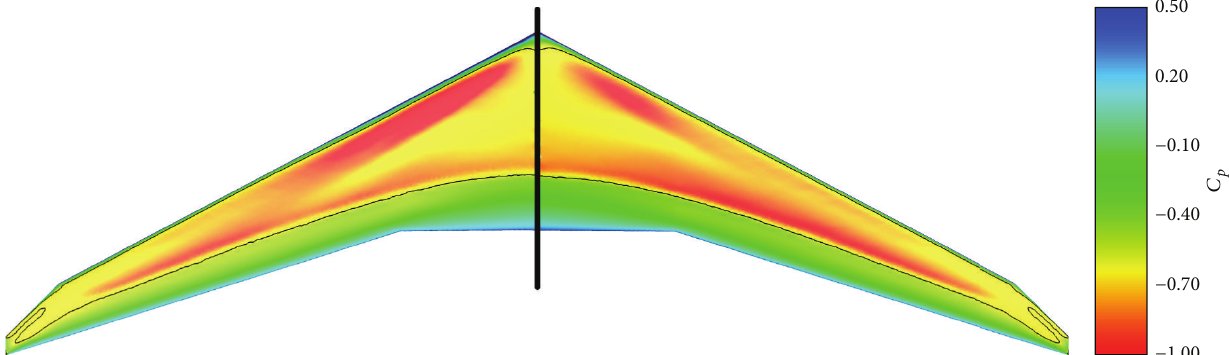
Figure 13: Comparison between the 𝐶 𝑝 distributions at cruise Mach over the reference wing (right) and over the wing equipped with morphing leading edge (left).